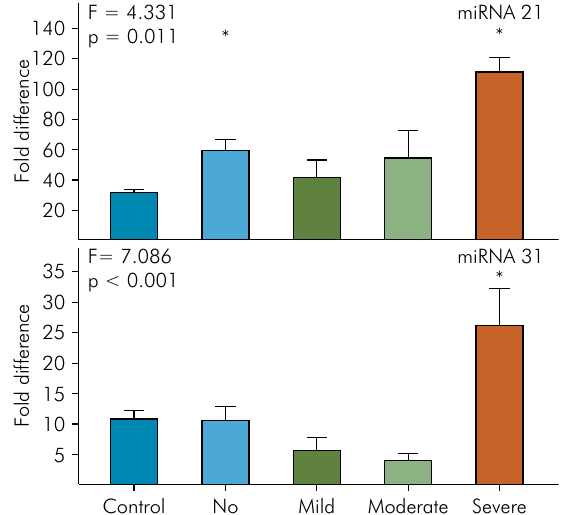
Figure 2. Mean of fold difference of miRNA-21 and miRNA-31 in varying grades of